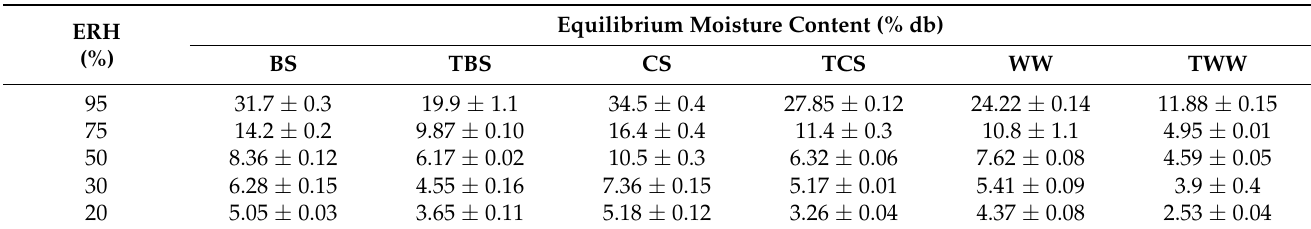
Table 4. Equilibrium moisture content (%) of raw and torrefied biomass at 300 ◦ C for 60 min.